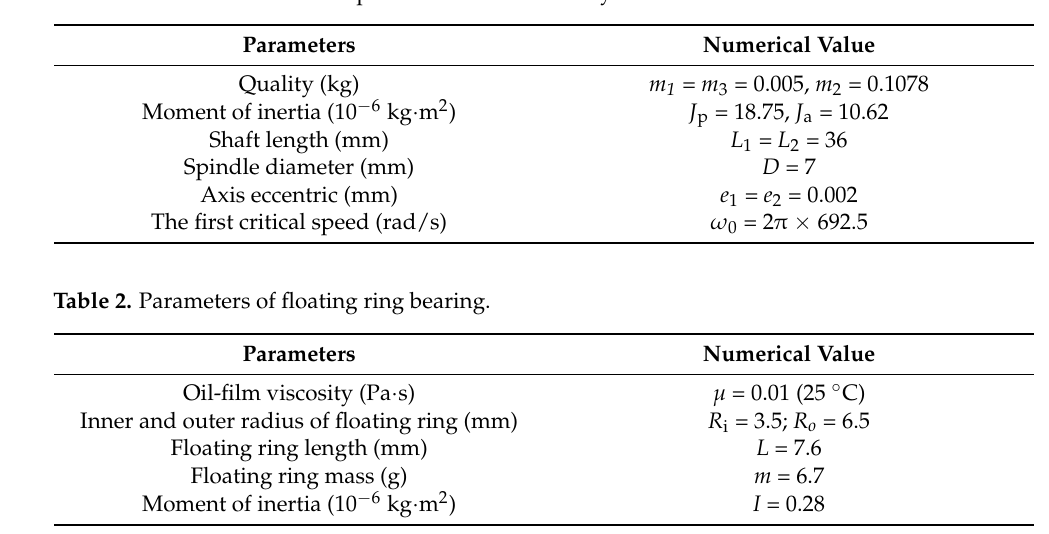
Table 1. Structural calculation parameters of the rotor system.